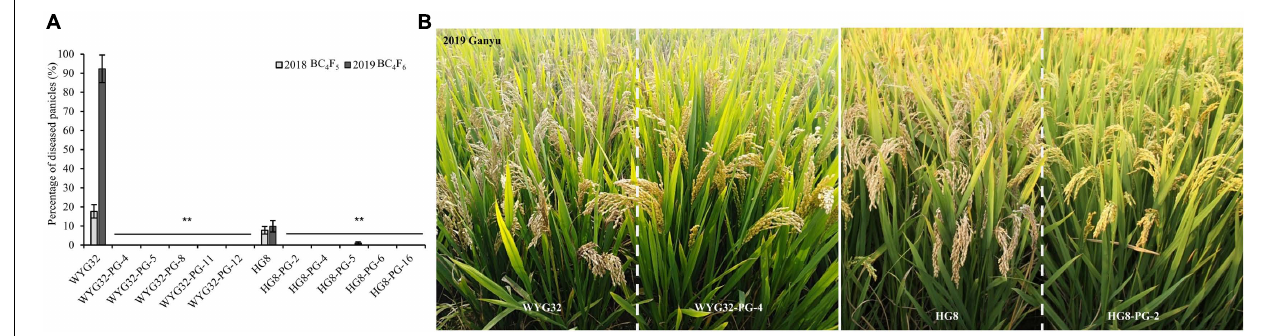
FIGURE 4 | Resistance levels of ABLs to panicle blast in a blast nursery. (A) Comparison of diseased panicle rates among ABLs and the recurrent parents (WYG32 and HG8). (B) Panicle blast disease reactions of partial ABLs in the field in 2019. ** P < 0.01 compared with the recurrent parent by Student’s t -test. TABLE 1 | Performance of basic agronomic and grain quality traits in ABLs and the recurrent parents. Cultivars/lines Plant height Days to Panicle Panicle Grain number 1,000-seed Seed setting Chalkiness Amylose (cm) heading number length (cm) per panicle weight (g) rate (%) rate (%) content (d)